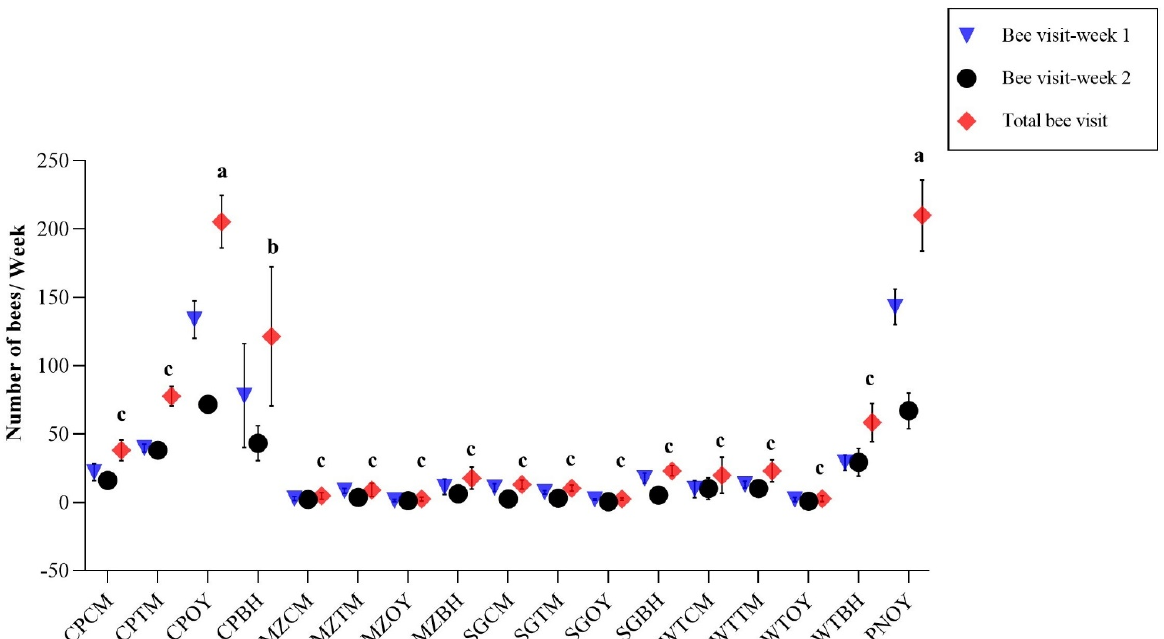
Figure 4. Honey bee visits towards different diet compositions. Whereas, CPCM = Chickpea flour + Cinnamon powder, CPTM = Chickpea flour + Turmeric powder, COPY = Chickpea flour only, CPBH = Chickpea flour + Both powders, MZCM = Maize flour + Cinnamon powder, MZTM = Maize flour + Turmeric powder, MZOY = Maize flour only, MZBH = Maize flour + Both powders, SGCM = Sorghum flour + Cinnamon powder, SGTM = Sorghum flour + Turmeric powder, SGOY = Sorghum flour only, SGBH = Sorghum flour + Both powders, WTCM = Wheat flour + Cinnamon powder, WTTM = Wheat flour + Turmeric powder, WTOY = Wheat flour only, WTBH = Wheat flour + Both powders, PNOY = Pollen only as a control. Different superscript letters indicate significant differences between total diet consumption.